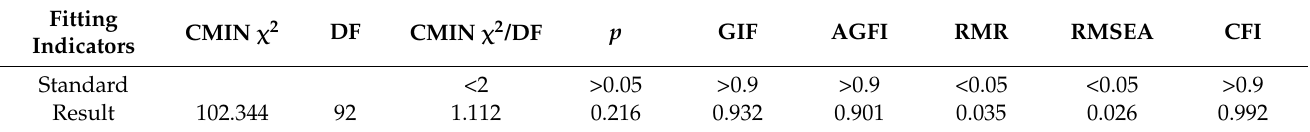
Table 2. Assumed model-fitting indicators of influential factors of miners’ risk